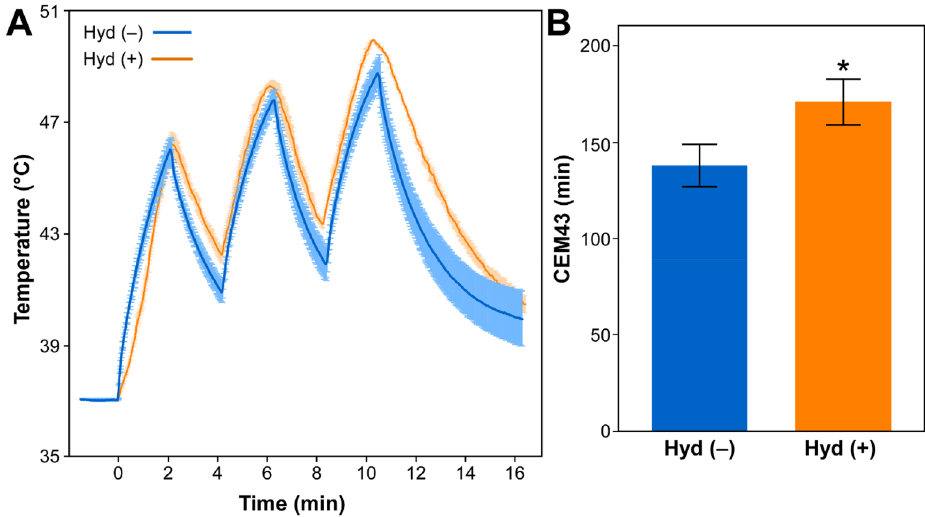
Figure 5. Tumor temperature and thermal dose (CEM43) measurement. ( A ) Graphs showing the average tumor temperatures (± SEM, colored bands) in live mice during ultrasound treatment with [orange, Hyd(+)] or without [blue, Hyd(−)] hydralazine. ( B ) Graph showing thermal dose (CEM43) calculated from the tumor temperature data for the ultrasound treatment groups with [orange, Hyd(+)] or without [blue, Hyd(−)] hydralazine. The difference in CEM43 values between Hyd(−) and Hyd(+) groups is statistically significant ( p <